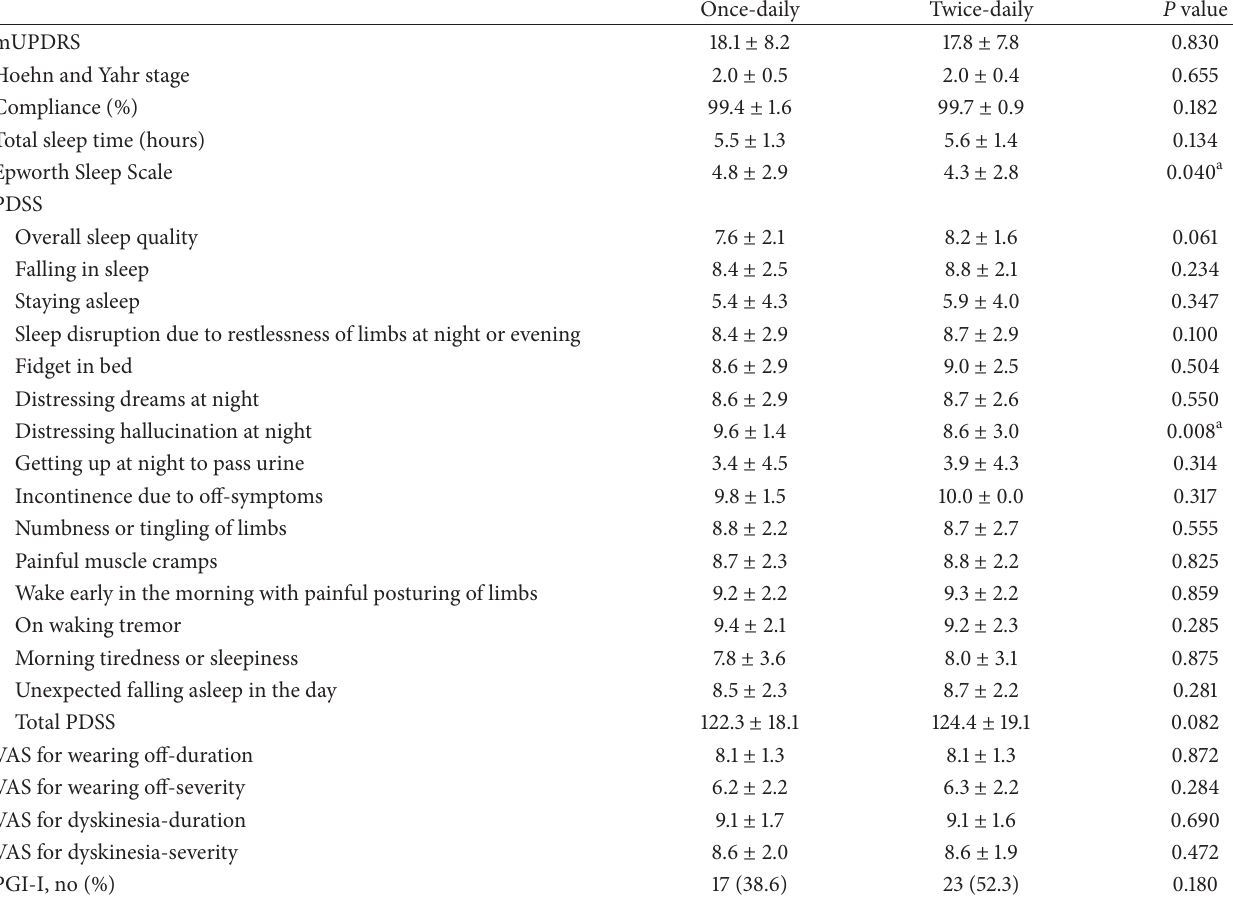
Table 3: Secondary outcomes in the per-protocol population.